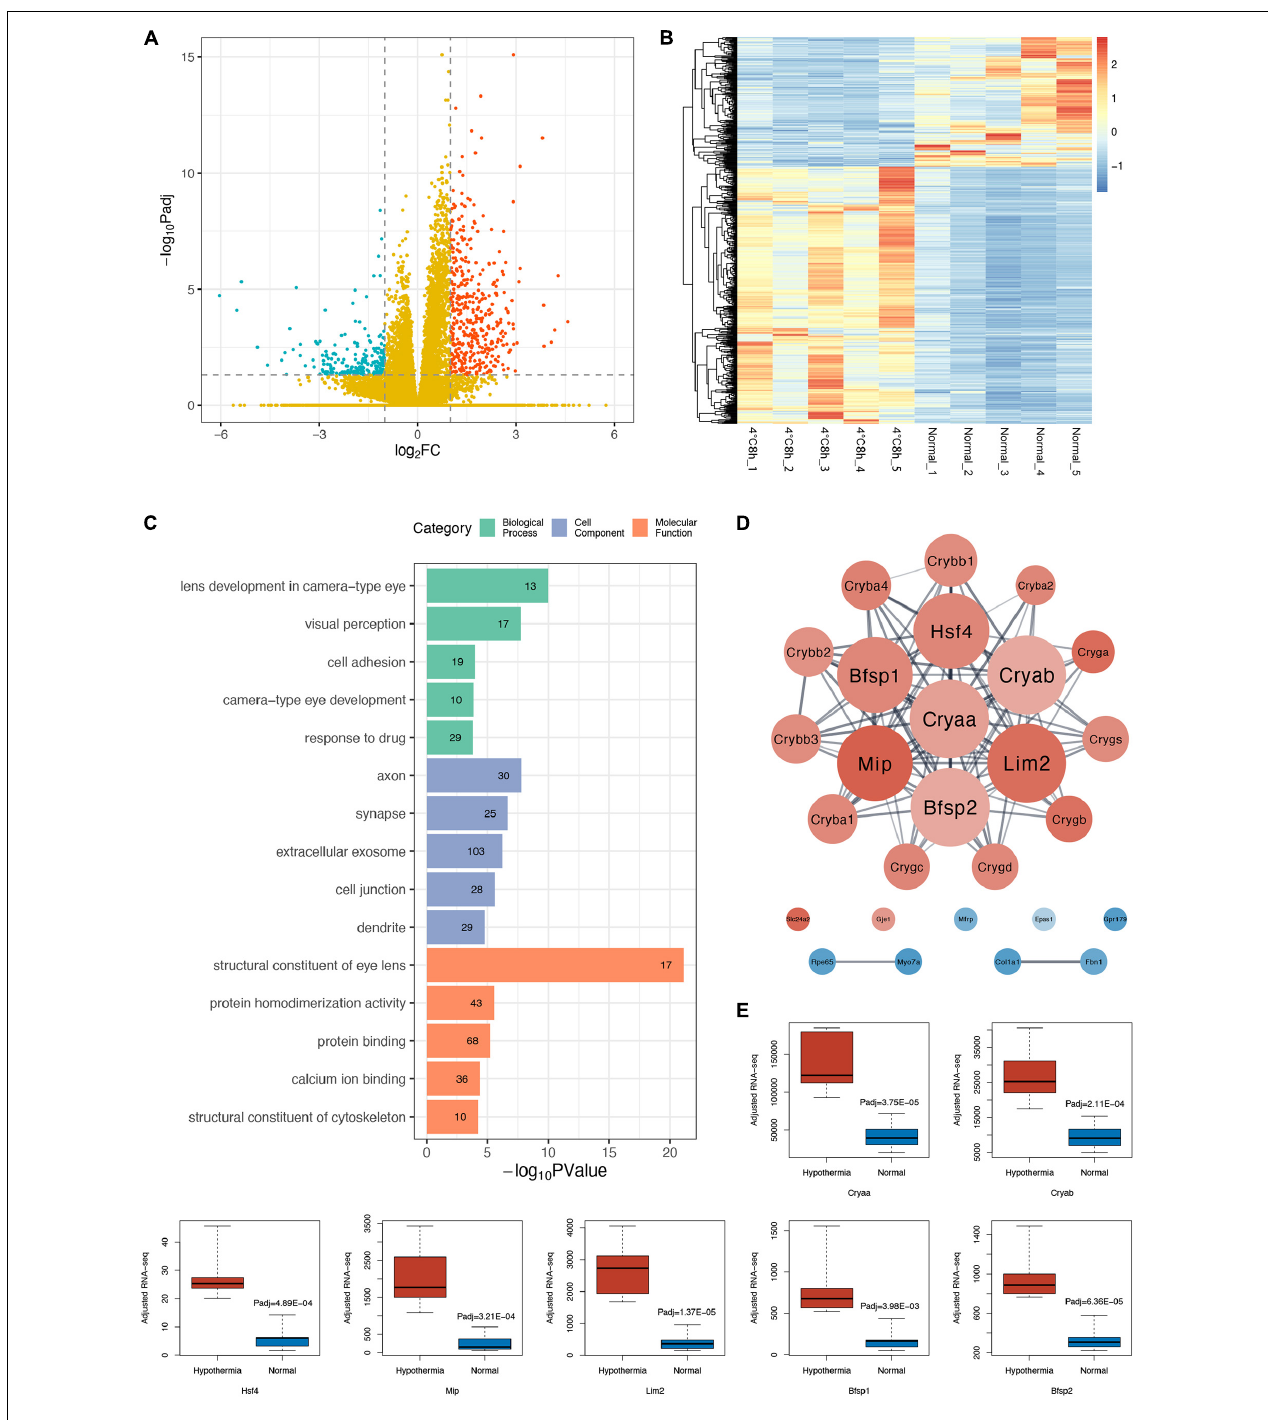
FIGURE 2 | Analysis of transcriptomic changes in cold treated lens capsules. (A) Volcano plots depict the log2FoldChange and statistical significance (|log2FoldChange| > 1), with the adjusted P -value expressed as − log10(adjusted P -value), the P -values were adjusted using the Benjamini and Hochberg method. Red points, green points, and yellow points represent up-regulated genes, down-regulated genes, and non-differentially expressed genes, respectively. (B) Heatmap of differentially expressed genes (DEGs) in the 10 samples. (C) Gene ontology (GO) analysis bar plot of DEGs. The top five GO terms with the lowest FDR values within each subcategory (BP, CC, MF) are listed. The number of DEGs annotated to the GO terms are shown on the bars. (D) Protein-protein interaction (PPI) network of DEGs annotated to the GO terms related to eyes. (E) Comparison of gene expression level of the hub genes in the PPI network between the two groups, adjusted RNA-seq means